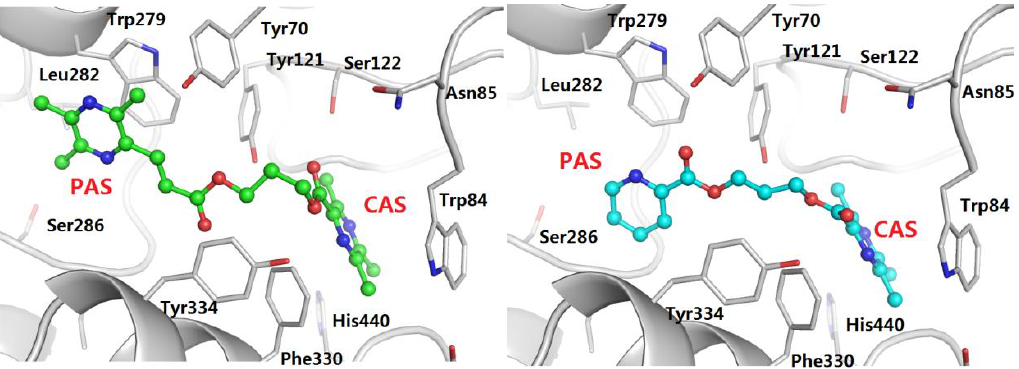
Figure 3. Binding modes of 8q (green carbon) and 8r (cyan carbon) obtained from molecular docking. Surrounding residues are depicted in grey (carbon), red (oxygen), and blue (nitrogen).